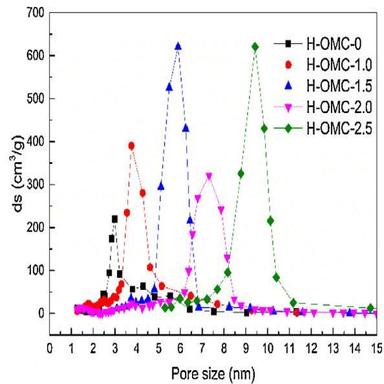
BJH pore size distribution curves of H-OMC-X mesoporous carbon materials.